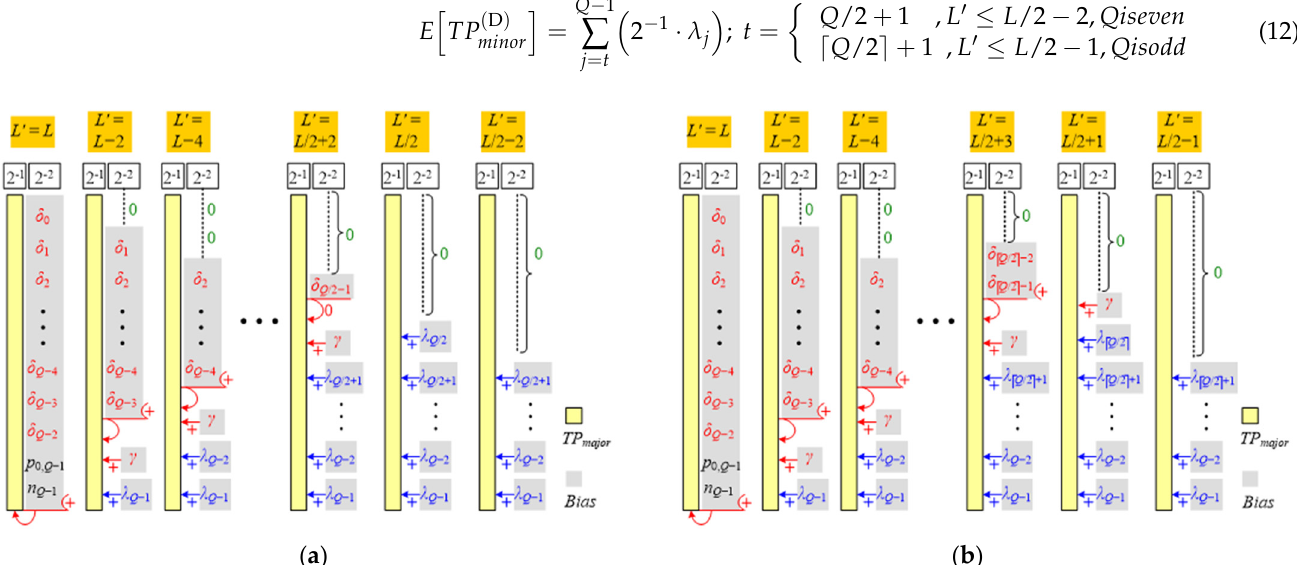
Figure 6. Schematic of BWATEC operations for various L ′ -bit input patterns of a general L -bit FWBM: ( a ) L = 2 n , and n is even; ( b ) L = 2 n , and n is odd.